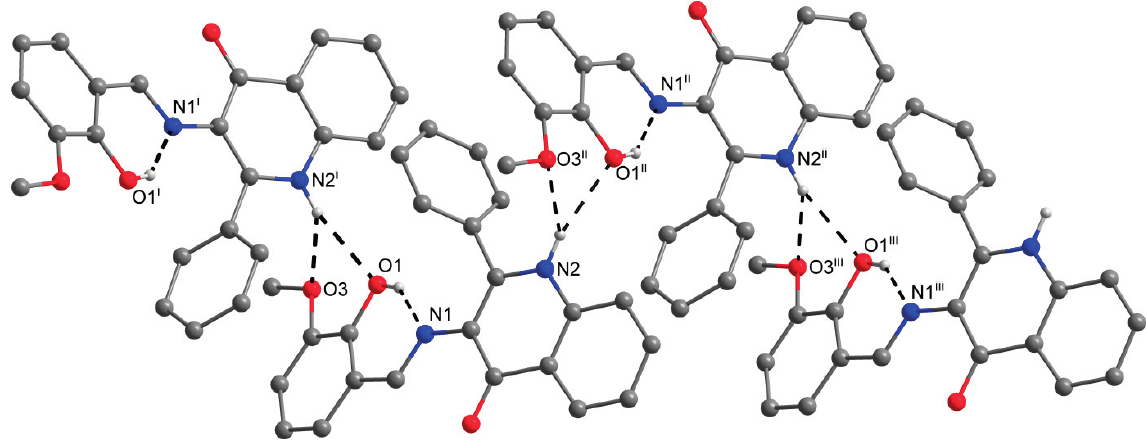
Figure 3. A part of the crystal structure of ( 3 ) showing the N − H···O and O − H···N hydrogen bonds (black dashed lines). The H–atoms not involved in the interactions are omitted for clarity. Symmetry codes: (i) 1 – x, –0.5 + y, 0.5 – z; (ii) 1 – x, 0.5 + y, 0.5 – z; (iii) x, 1 + y, z.